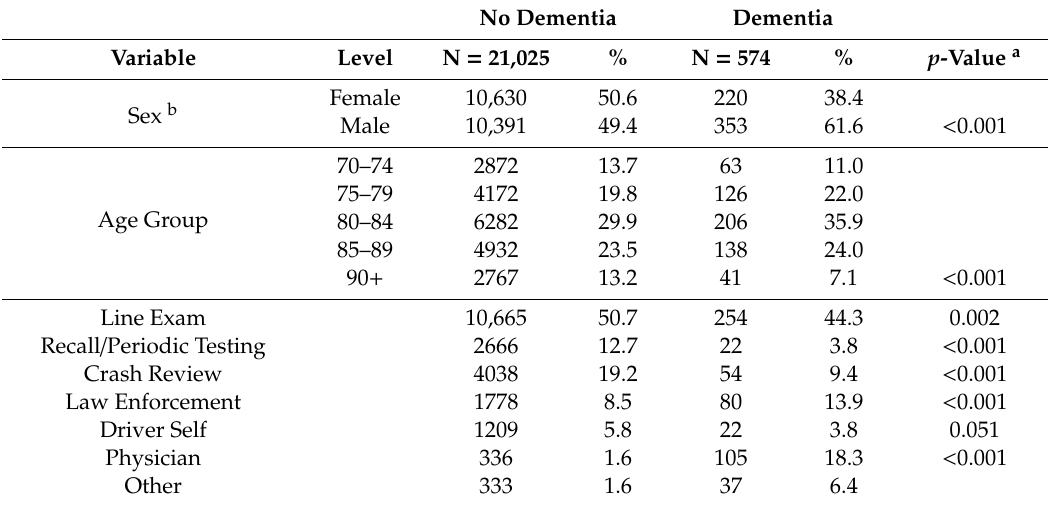
Table 1. Demographics and referral source of